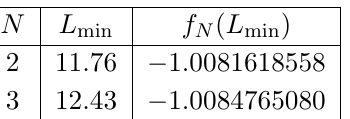
Table 11 . Local minimum values of f N ( L ) for N = 2 ; 3 in Schnabl gauge.